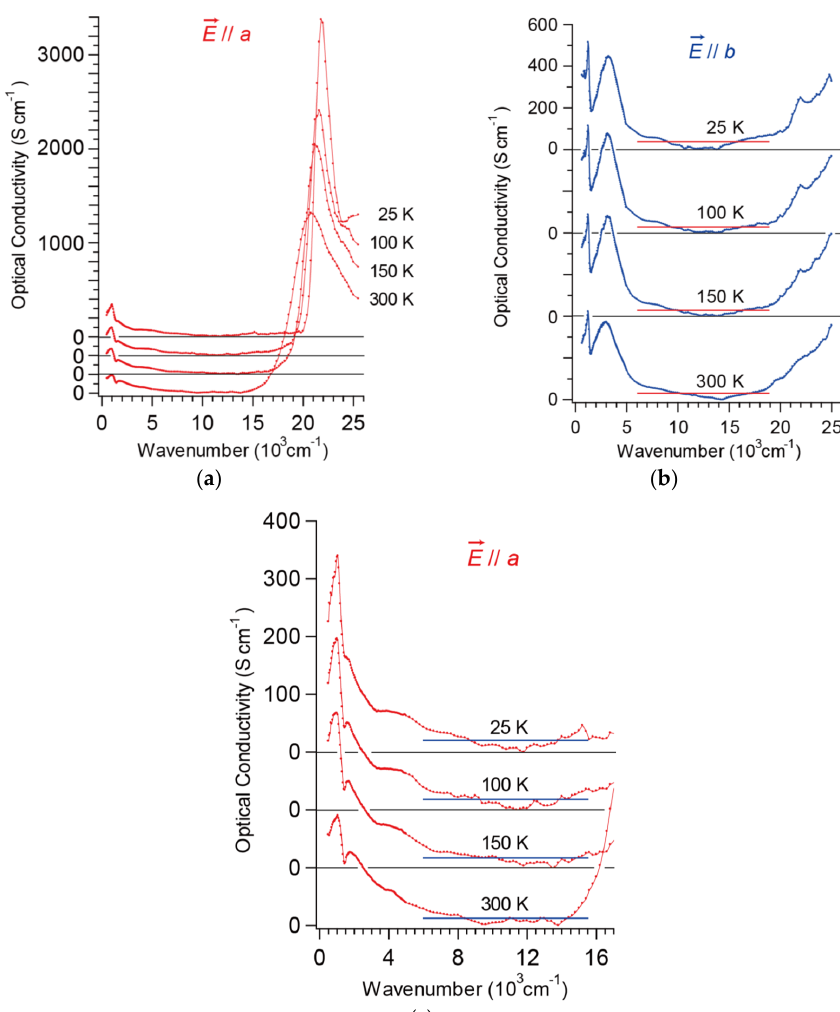
Figure 6. Temperature-dependent reflectance spectra of  -STF 2 I 3 . The spectra measured with setting the polarization, i.e., the alignment of electric field ( E -vector) in the incident light along the crystallographic: ( a ) a -axis; ( b ) b -axis. Note that each spectrum at 150, 100 and 25 K is offset by 20%, 40% and 60%, respectively in Figure 6a,b.